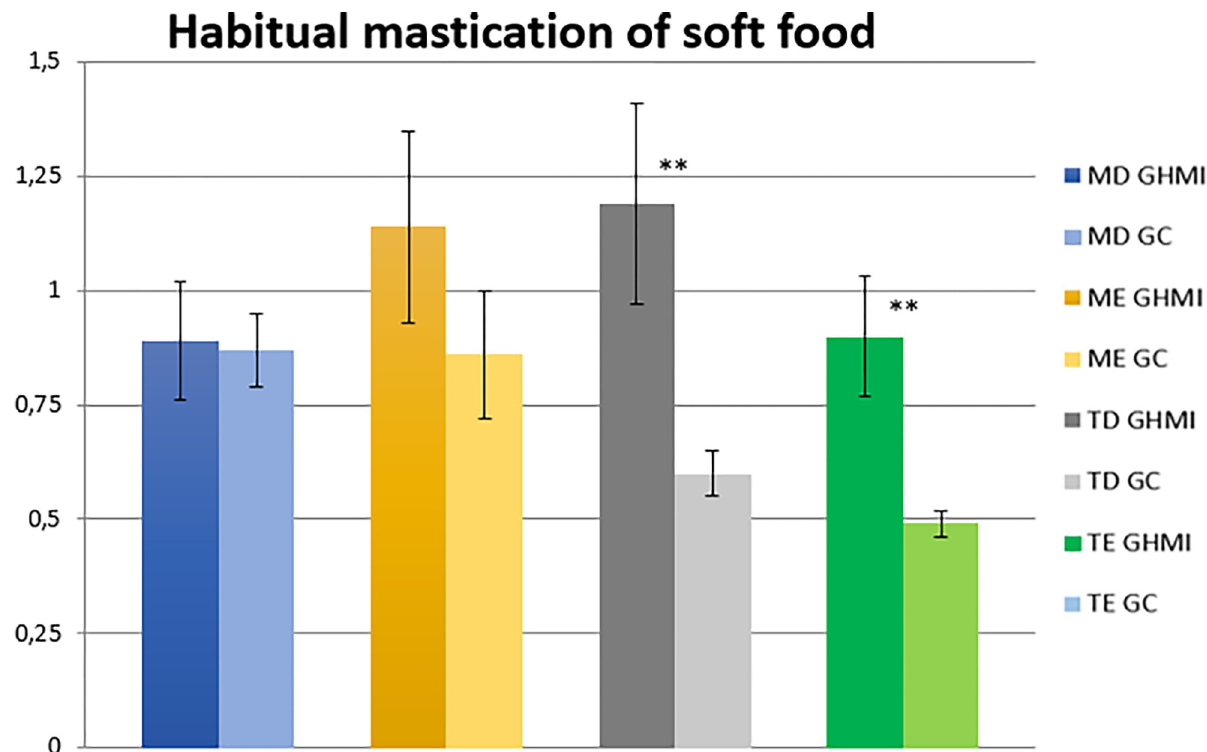
Fig 7. Normalized electromyographic means (RMS) in the habitual mastication of soft food condition for the right masseter (RM), left masseter (LM), right temporal (RT) and left temporal (LT) muscles, in the MIH (MIHG) and control (CG) groups. MIH, Molar-incisor